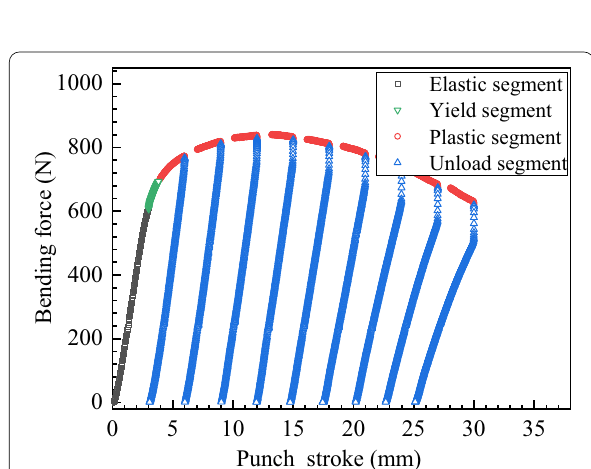
Figure 9 Segmented loading and unloading force-stroke